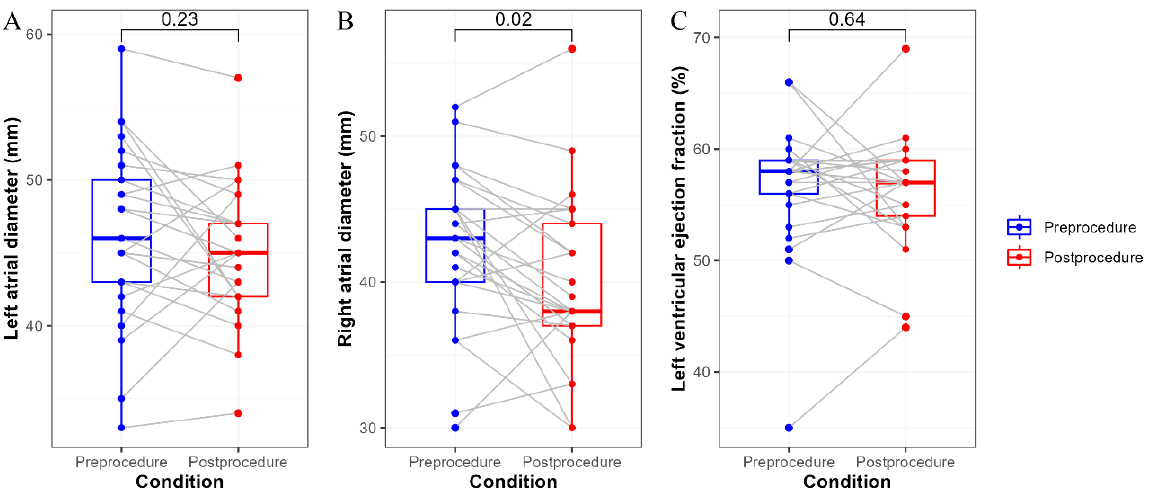
Figure 4. Cardiac function pre ‐ and post ‐ ethanol infusion. Panel ( A ) Changes in the left atrial diam ‐ eter; Panel ( B ) Changes in the right atrial diameter; Panel ( C ) Changes in the left ventricular ejection fraction. Variables were compared using the paired t ‐